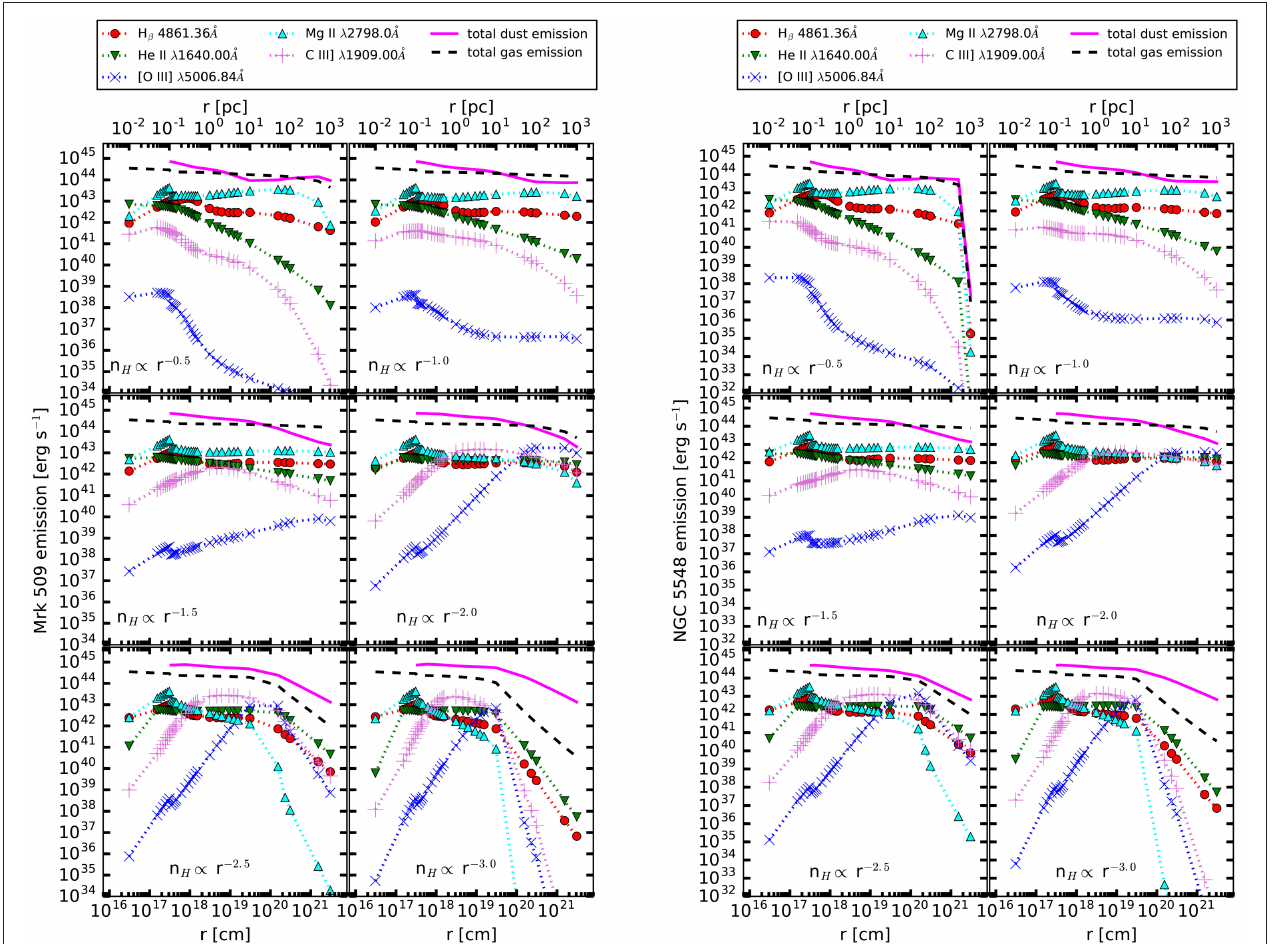
FIGURE 1 | Left : Line emission vs. radius for Mrk 509 SED. Different subplots are for various density slopes given in the left corners. Major emission lines: H β (red circles), He II (green triangles down), [O III] (blue crosses), Mg II (cyan triangles up) and [C III] (magenta pluses) are shown for each density profile cases. For clarity total dust emission (magenta continuous line) and total gas emission (black dashed line) are also shown. Right : The same as in left but with the spectral radiation shape of NGC